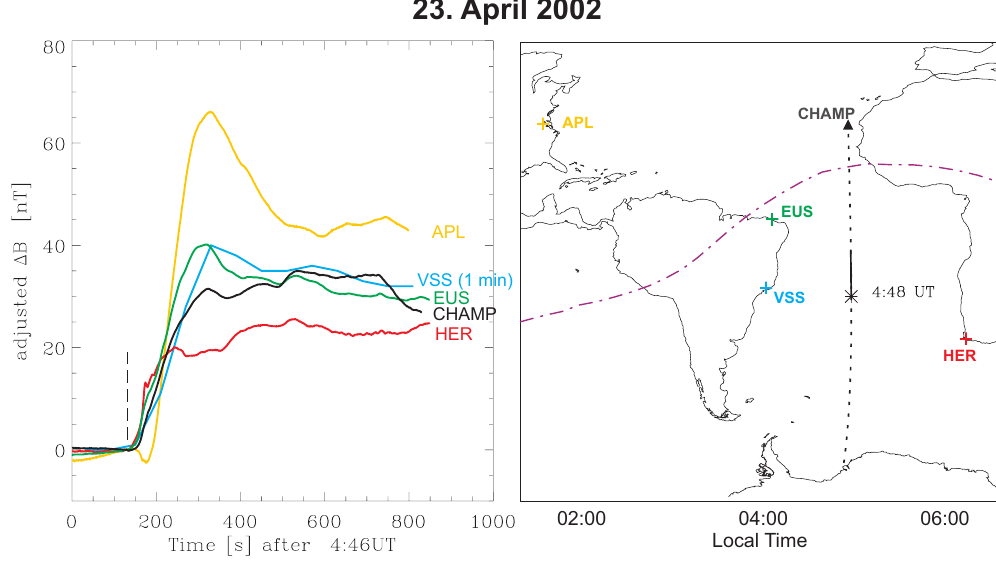
Fig. 4. Same as Fig. 2, but for the SC event on 23 April 2002, when CHAMP flew over the Atlantic.